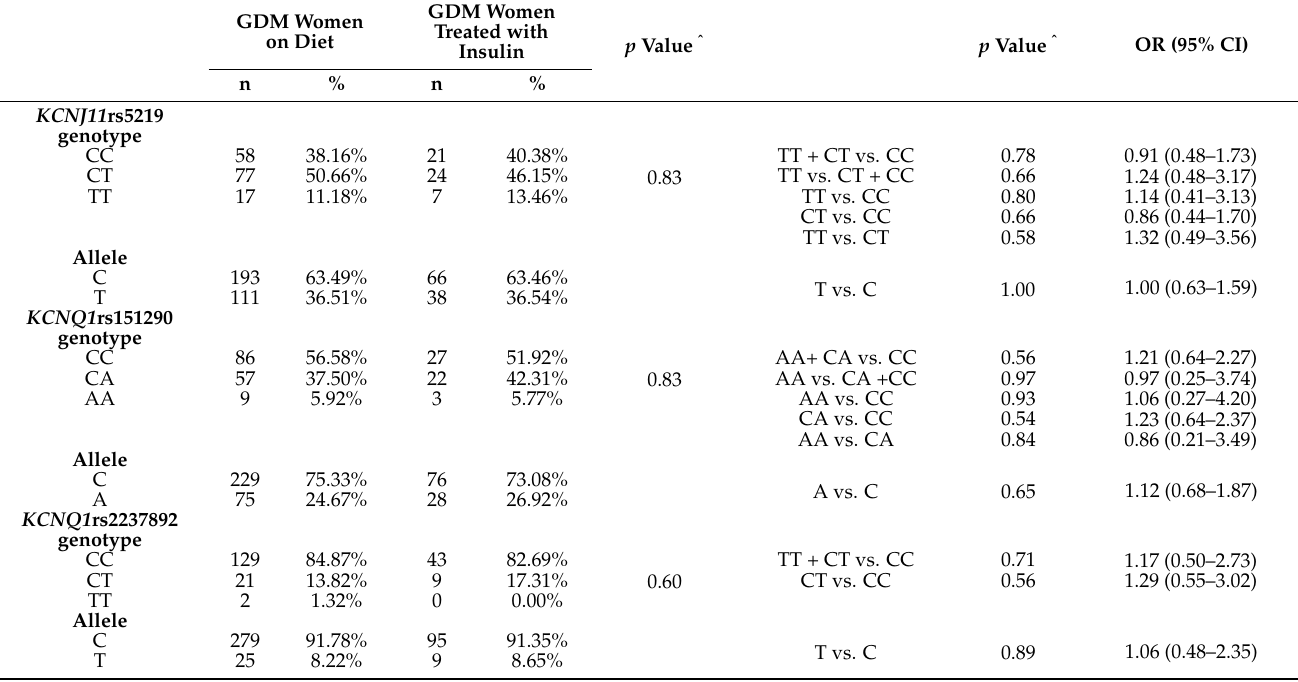
Table 4. Distribution of KCNJ11 and KCNQ1 genotypes in GDM women treated with insulin and GDM women on